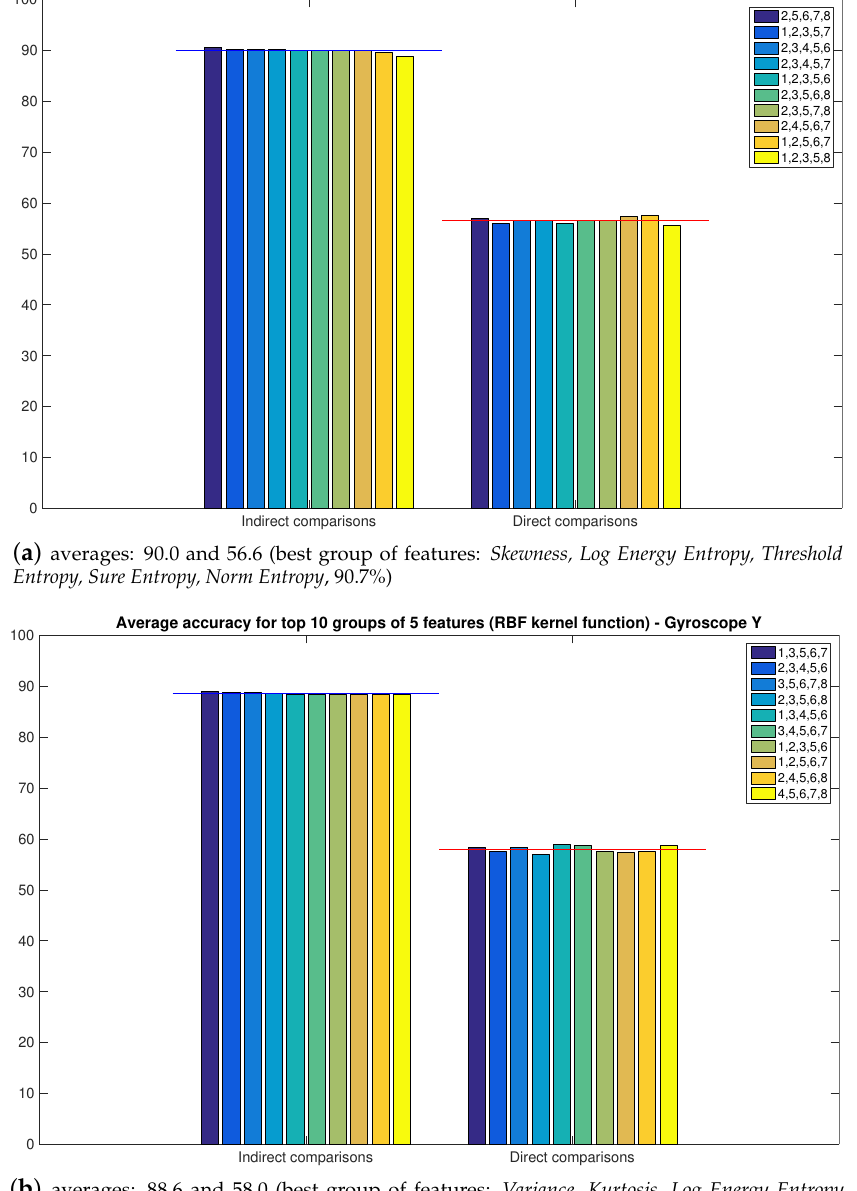
Figure 9. Accuracy for top 10 groups of five features for Gyroscope x and y